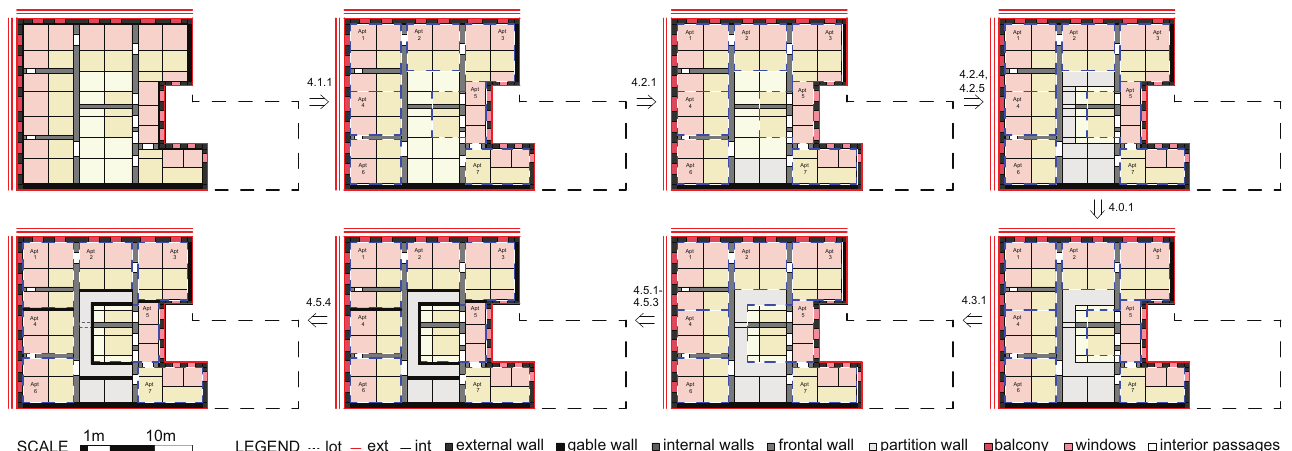
Figure 10. Derivation process considering steps for stage 4 for the case study building